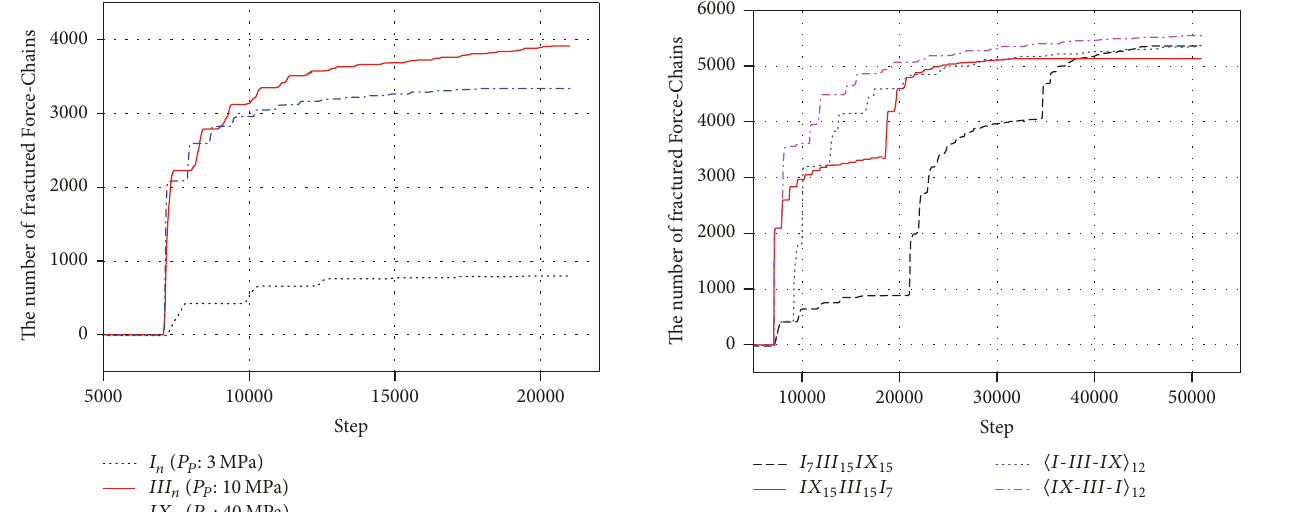
Figure 14: Growth curves of fractured Force-Chains under repeated-impacts of HWSWs with different